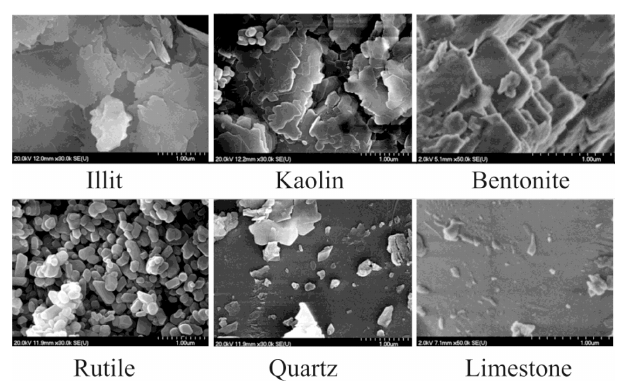
Figure 4. SEM pictures of collected aerosol